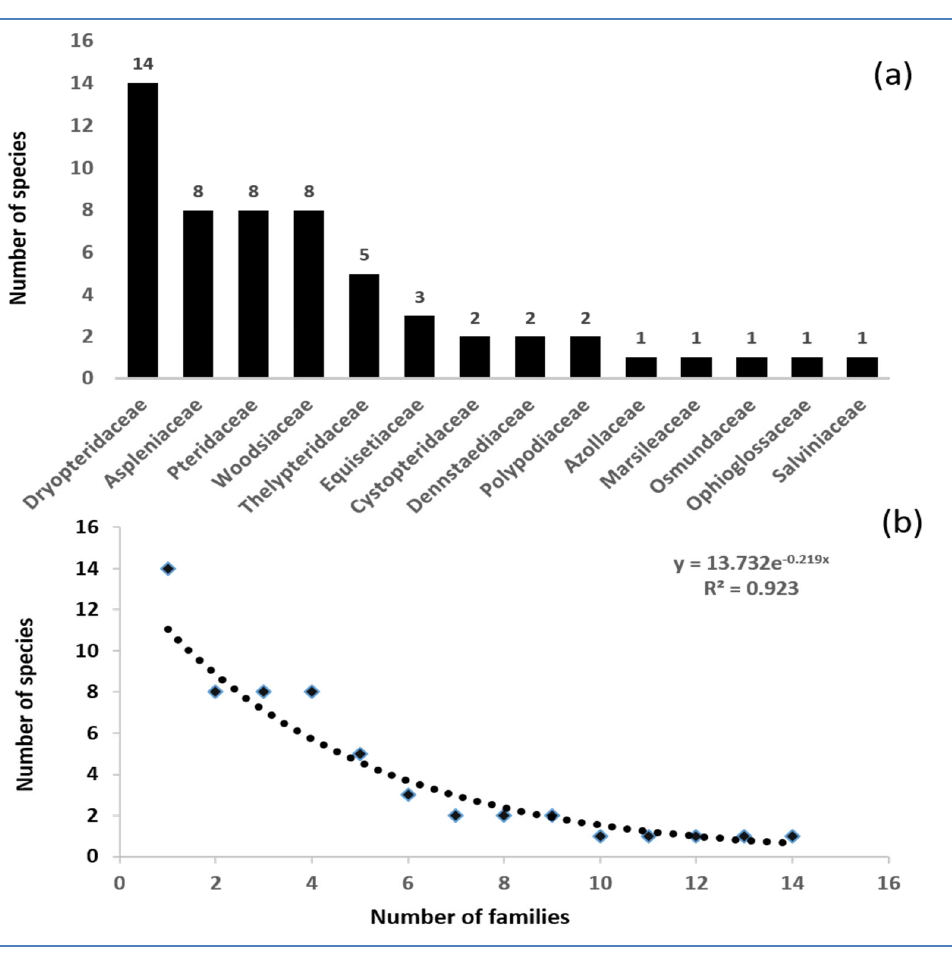
Figure 2. ( a ) Percentage of families; ( b ) species–family relationship of the documented species in the study area.